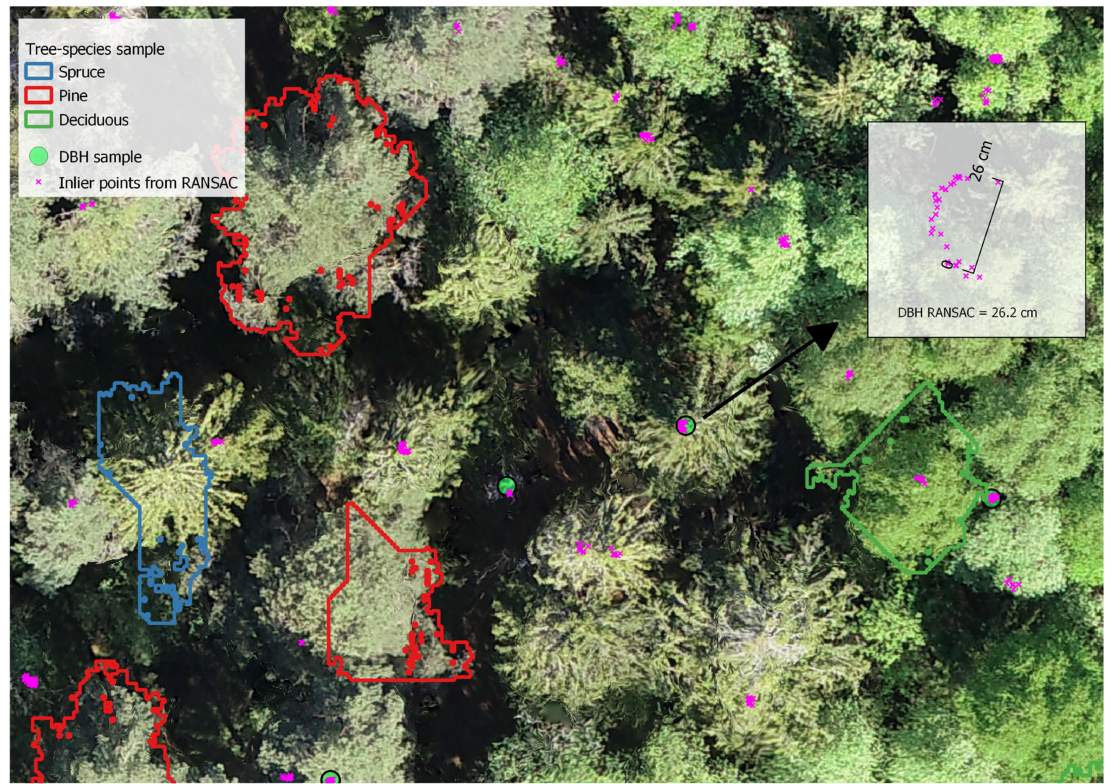
Figure 4. Overview of the information acquired through a manual interpretation of the point cloud and orthomosaic for DBH measurements and tree species information. The polygons in blue, red, and green represent the segmented tree crowns and the small inner polygons represent small gaps (i.e., no returns) within that